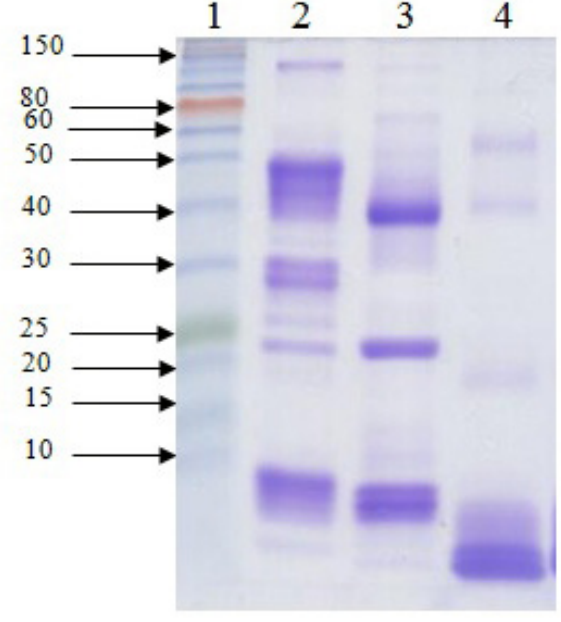
1. SDS-PAGE profiles of venoms. Electrophoretic separation of venom was performed on a vertical slab of 15% acrylamide under reducing conditions. Lane 1: molecular mass markers (kDa); lane 2: Cerastes cerastes venom sample; lane 3: Macrovipera mauritanica venom sample; and lane 4: Naja haje venom sample. The markers indicated on the left are expressed as kDa. Gel was stained using Coomassie